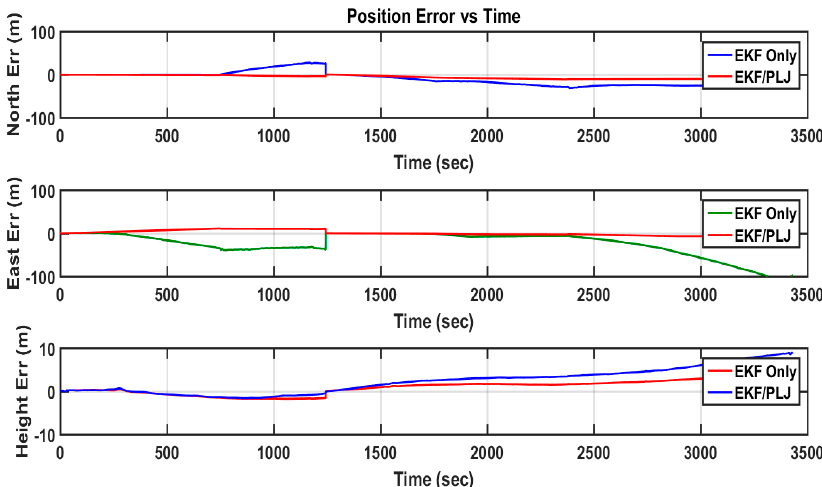
Figure 12. Position Errors-EKF & EKF/PLJ Scenario #1.